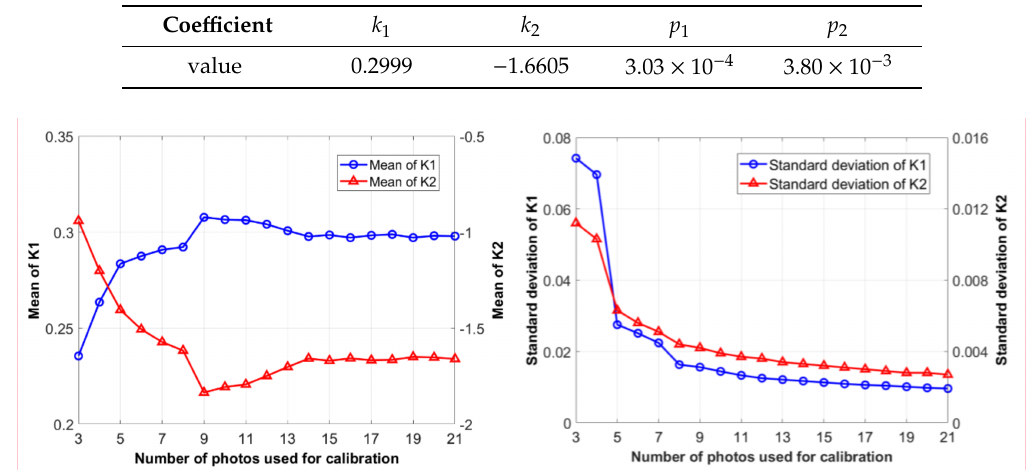
Figure 2. Identification trend of radial distortion coe ffi cients.